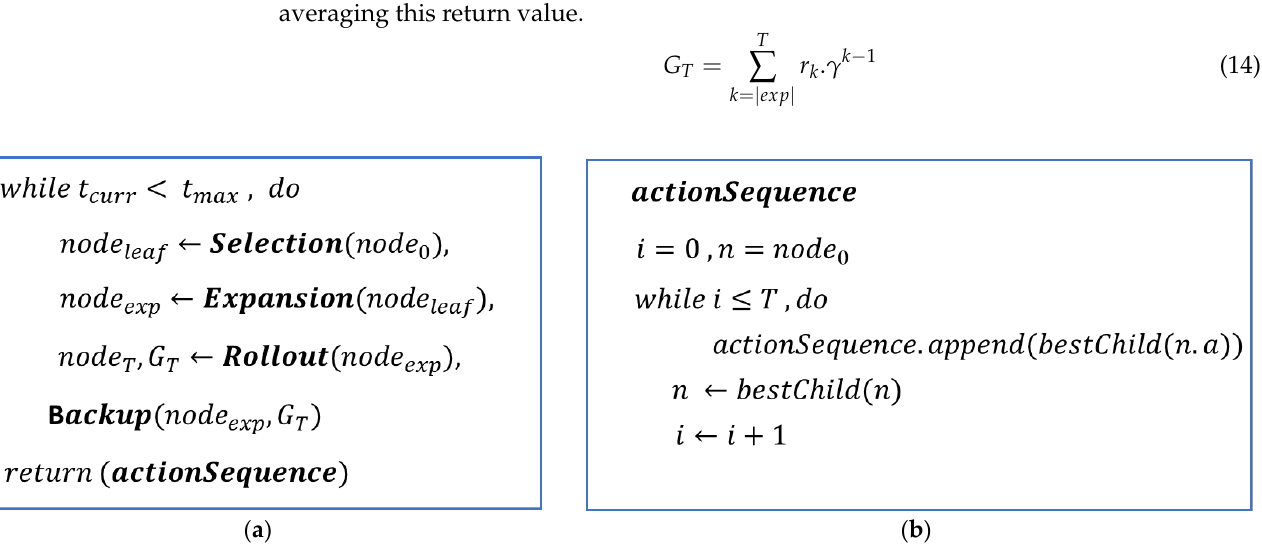
Figure 12. ( a ) MCTS algorithm ( b ) Action sequence selection method.